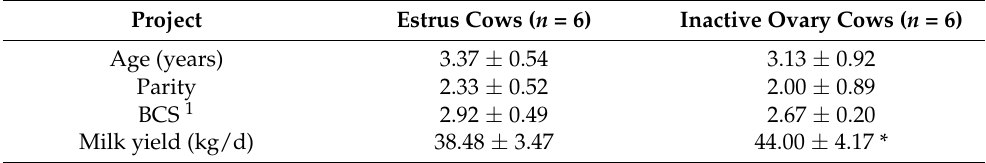
Table 1. Clinical information in the two groups of tested cows.